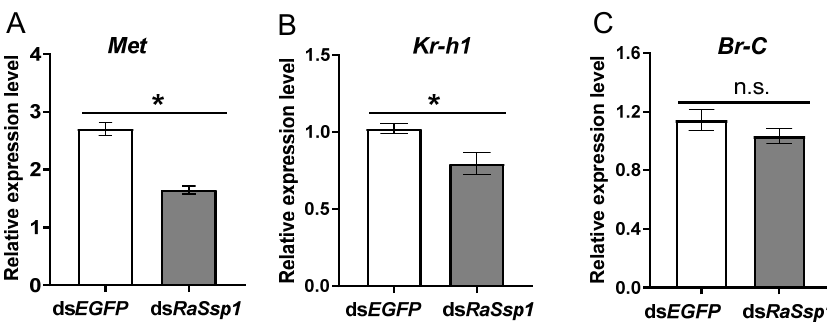
Figure 4. The expression levels of JH signal related gene in the head of workers on the 3rd day after injection of RaSsp1 dsRNA. RaSsp1 dsRNA was injected at the beginning of the gut-purging period in workers, with EGFP dsRNA as control. ( A ) Met , ( B ) Kr-h1 , ( C ) Br-C . Asterisks indicate a significant difference (one-way ANOVA followed by LSD test using SPSS, * p < 0.05).